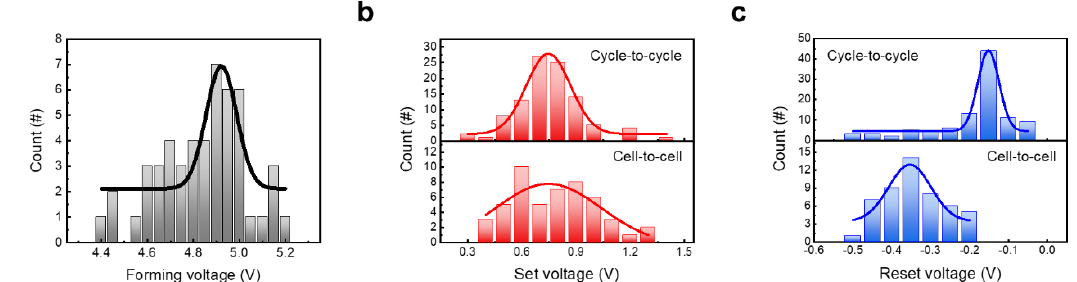
Figure 5. Switching voltage variability. ( a ) Forming voltage variability in 50 cells. ( b , c ) Set and reset voltage, respectively. To measure cycle-to cycle and cell-to-cell variability, the switching voltage was extracted in 100 cycles and 50 cells, respec- tively.